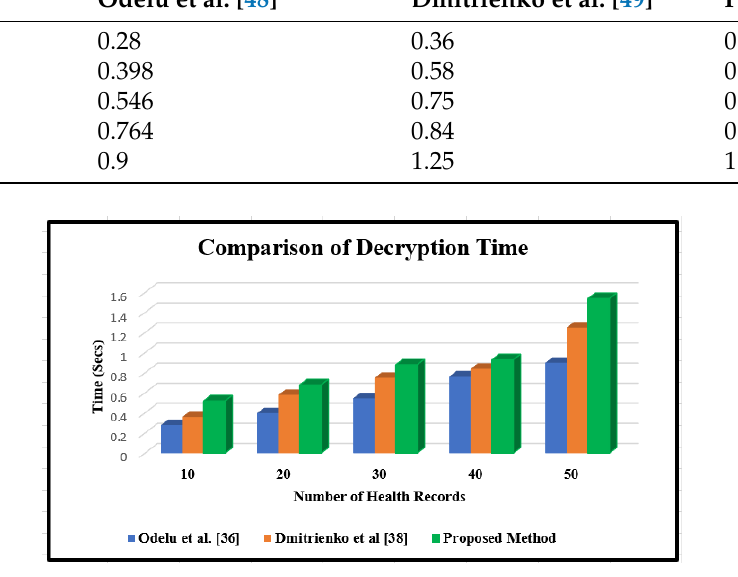
Figure 14. The decoding time in IoT